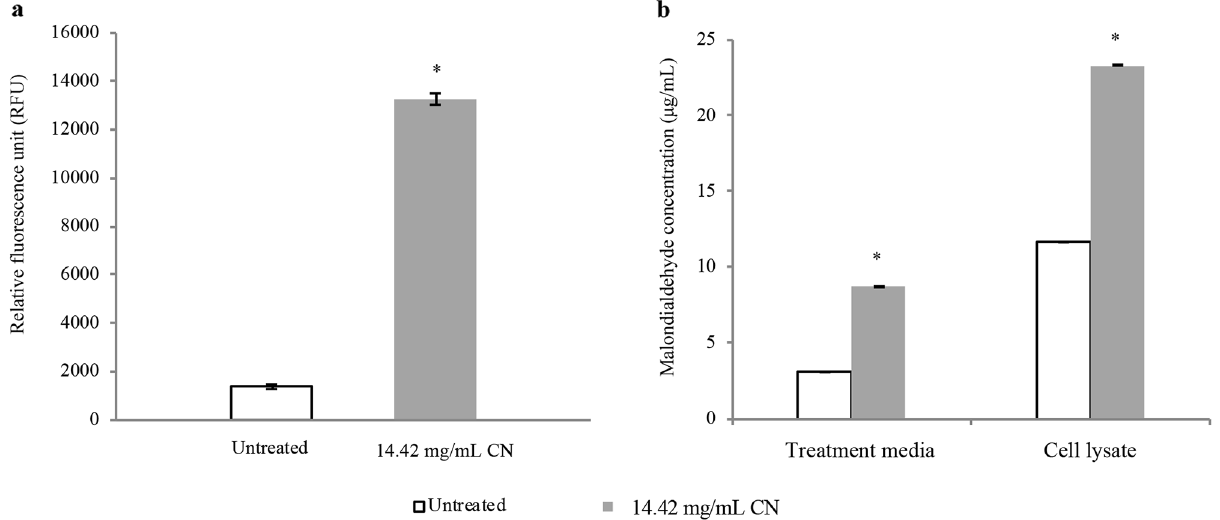
Figure 3. Oxidative stress assessment via ( a ) ROS measurement using DCF-DA and ( b ) lipid peroxidation assay in treated and untreated KPC-KP cells. The mean ± SD for three replicates is illustrated. Data were analysed by Student’s t-test with * P < 0.05 being significantly different from the untreated KPC-KP